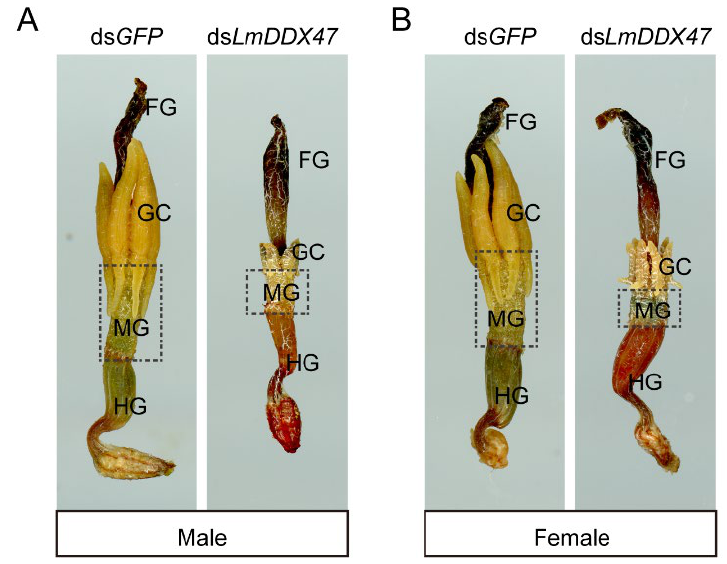
Figure 2. Effects of LmDDX47 RNAi on the intestinal tract of adult locusts. ( A , B ) Intestinal morphol- ogy of the adult male ( A ) and female ( B ) migratory locust after LmDDX47 RNAi. FG: foregut; GC: gastric cecum; MG: midgut; HG: hindgut.